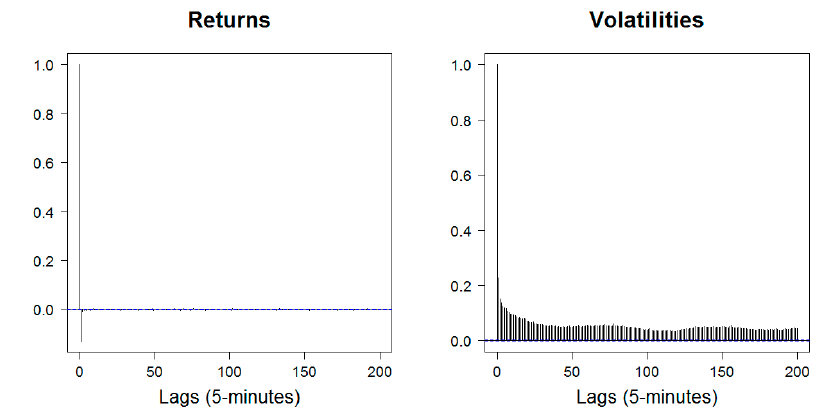
Figure3. Auto-correlogramsofUSD / AUDhigh-frequencyreturnsandvolatilities. Notes: Exchange-rate returns are computed as the log-change of the corresponding five-minute closing spot rates: r it = log p it − log p i , t − 1 ( t = 1, ... , 8193). Volatilities are defined as the one-day rolling standard deviations of r it . Source: Authors’ computations.